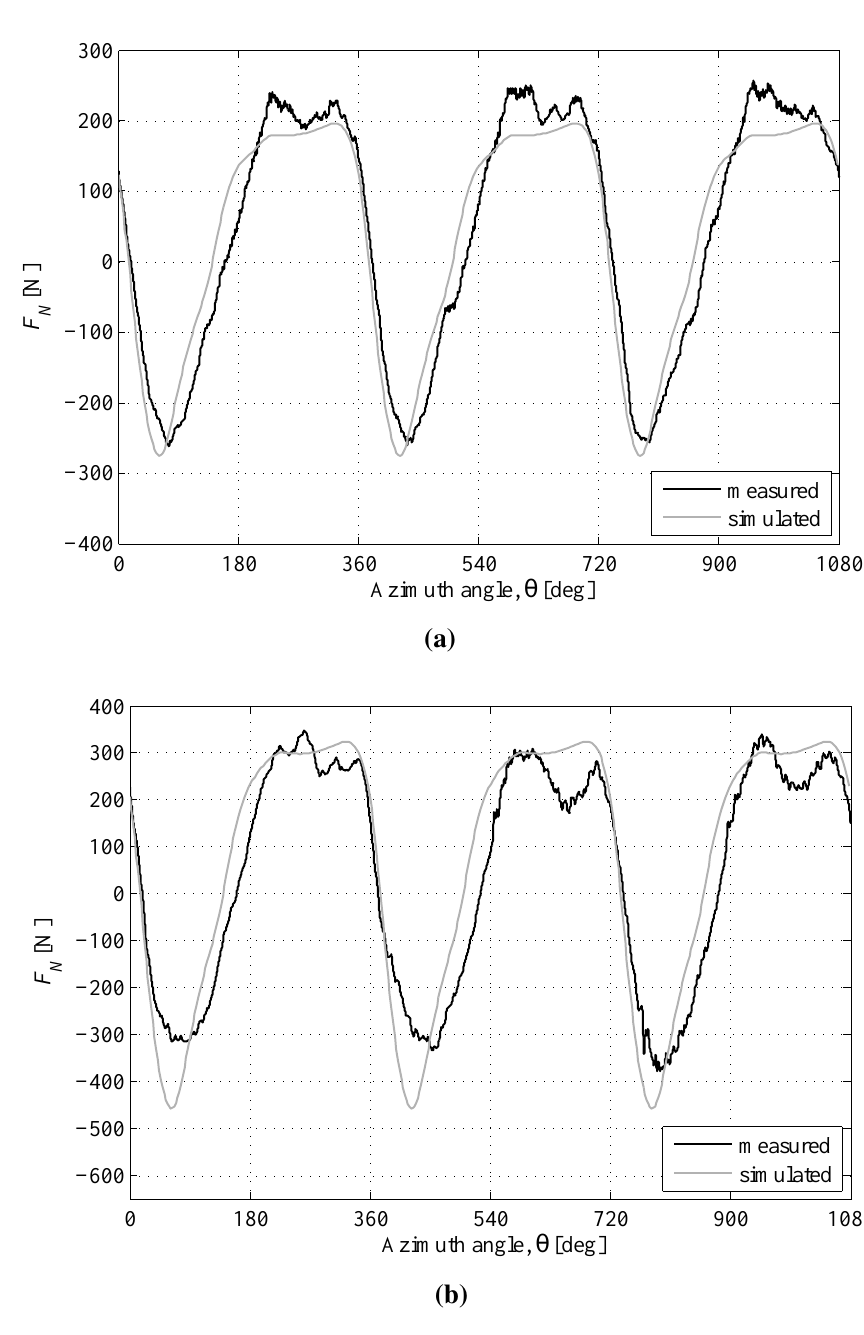
Figure 10. Comparison of measurements and simulations of F speeds. ( a ) Normal force response at λ = 3 . 59 and (cid:104) Ω ρ = 1 . 275 kg / m 3 ; ( b ) Normal force response at λ = 3 . 58 and (cid:104) Ω Air density ρ = 1 . 236 kg / m 3